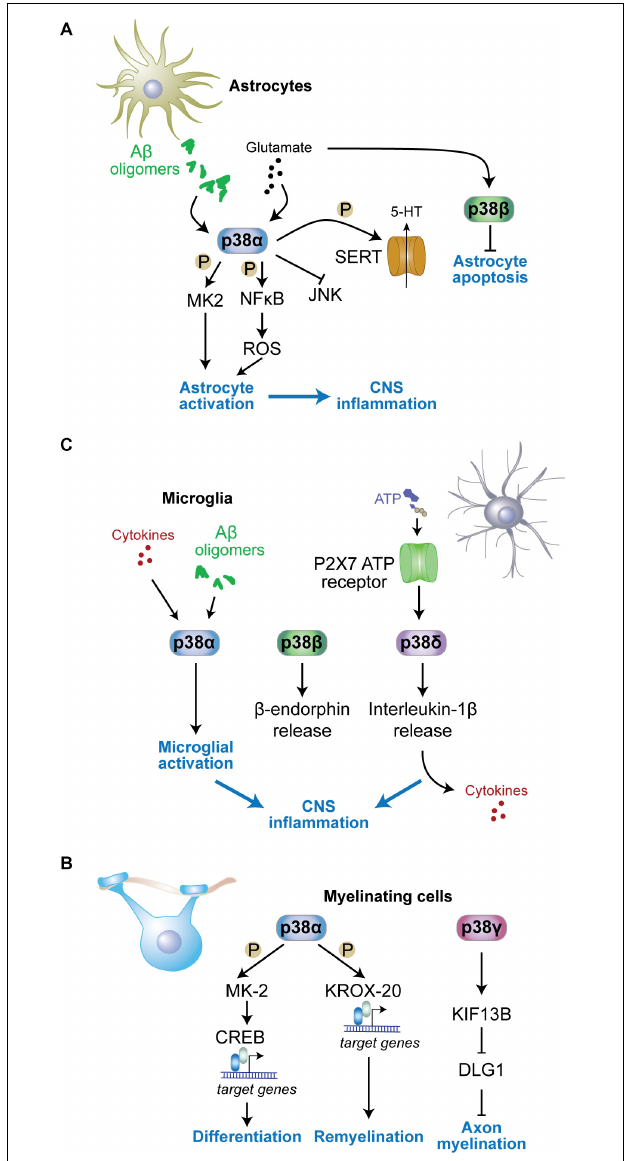
FIGURE 3 | Functions of p38 kinases in non-neuronal cells. (A) In astrocytes, p38 α is activated by stimuli including amyloid- β oligomers or excess glutamate and contributes to astrocyte activation and neuroinflammation. MK2 is activated in astrocytes downstream of p38 α . p38 α activates NF κ B resulting in reactive oxygen species (ROS) production and astrocyte activation. Astrocyte p38 α inhibits c-jun N-terminal kinase (JNK) activity, and enhances serotonin (5-HT) uptake into astrocytes through phosphorylation of serotonin transporter (SERT). p38 β is also activated by glutamate in astrocytes yet contributes to astrocyte survival by inhibiting apoptosis. (B) In myelinating cells, p38 α promotes remyelination through phosphorylation of key myelin transcription factor KROX-20 and downstream gene expression. p38 γ contributes to diameters of myelin sheaths by reducing levels of disks large homolog 1 (DLG1), a inhibitor of myelination, through control of KIF13B levels. (C) In microglia, p38 α is activated by stimuli including cytokines and amyloid- β oligomers, while microglial p38 δ is activated downstream of P2 × 7 adenosine triphosphate (ATP) receptors. Both active p38 α and p38 δ contribute to neuroinflammation by promoting further cytokine release from microglia. p38 β promotes release of microglial β